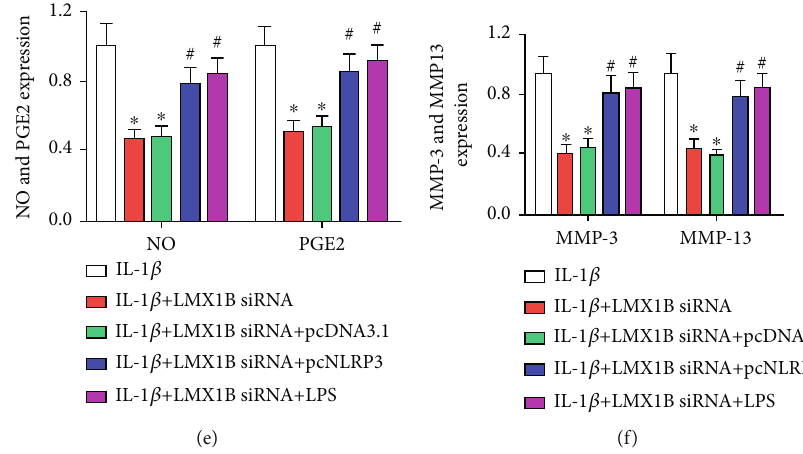
Figure 8: NLRP3 overexpression or NF- κ B activation reversed the e ff ects of LMX1B silence on SW1353 cell biology. (a) CCK-8 analysis for SW1353 cell survival; (b) 5-ethynyl-2 ′ -deoxyuridine (EdU) assay was used to determine SW1353 cell proliferation; (c) SW1353 cell apoptosis was detected by using fl ow cytometer analysis. (d) ELISA kits were used to determine the expression of IFN- γ , TNF- α , IL-6, and PGE2; (e) NO and PGE2 concentration was determined by the Griess reaction and ELISA kit, respectively; (f) ELISA kits were used to determine the expression of MMP3 and MMP13. SW1353 cells were transfected with LMX1B siRNA for 24h by using Lipofectamine 2000 reagent and then treated with 10 ng/ml IL-1 β for 24h or SW1353 cells were cotransfected with LMX1B siRNA and pcDNA3.1 control vector or LMX1B siRNA and pcDNA3.1-NLRP3 vector for 24h and then treated with 10 ng/ml IL-1 β for 24h, or SW1353 cells were treated with 10ng/ml IL-1 β and LPS (400 μ g/ml) for 24 h. ∗ P < 0 : 05 , compared with the IL-1 β group; # P < 0 : 05 , compared with the IL-1 β +LMX1B siRNA group. All experiments were repeated three times.